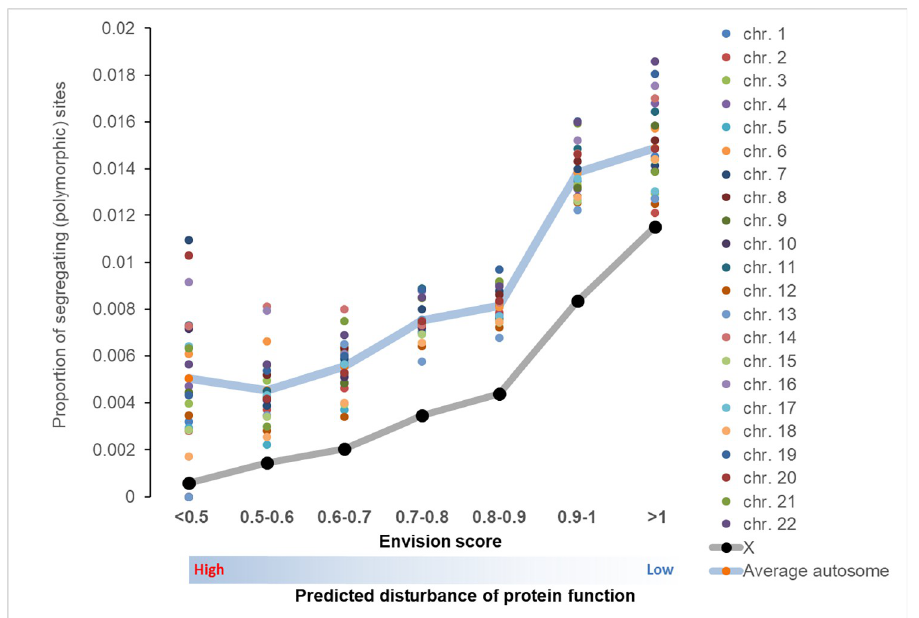
Fig 8. The proportion of segregating sites for missense mutations categorized by Envision score. The lower envision score is associated with a stronger effect on protein function. Of note, there is a higher inter chromosomal variation in the proportions of segregating sites on the tails of the distribution because of small sample sizes for those categories (see S6 Table).